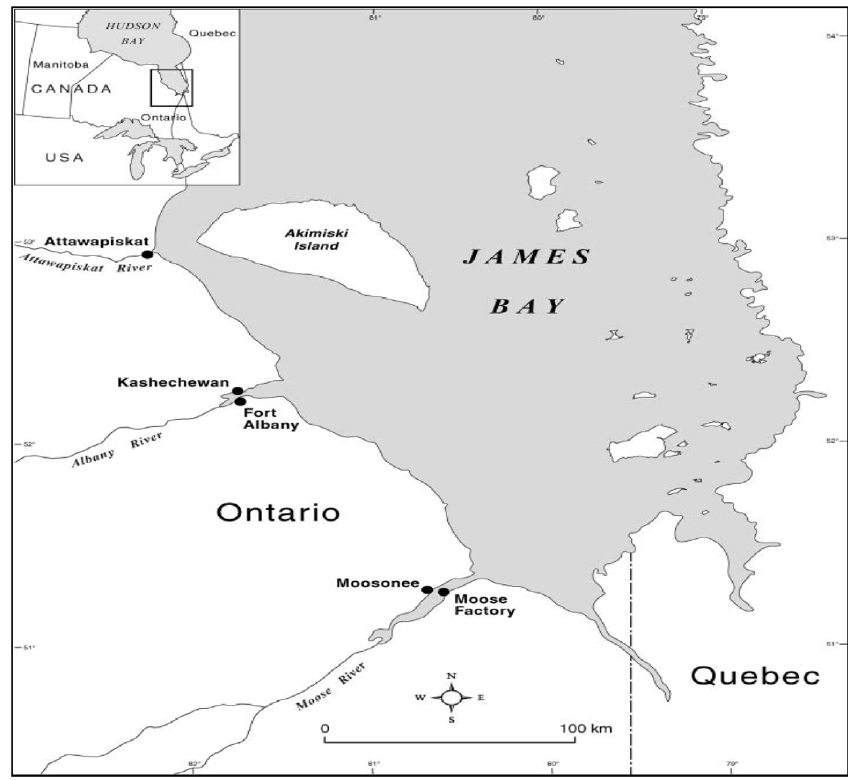
Map of the Mushkegowuk Territory in western James Bay, Ontario, Canada (Karagatzides et al.,